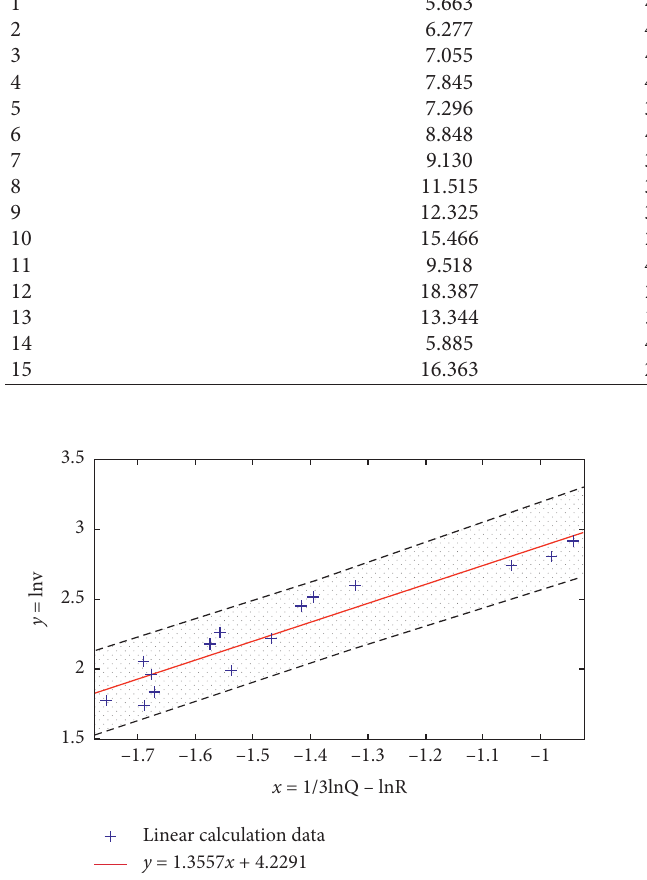
Figure 13: Fitted curve of the Sadove regression for the No. 0